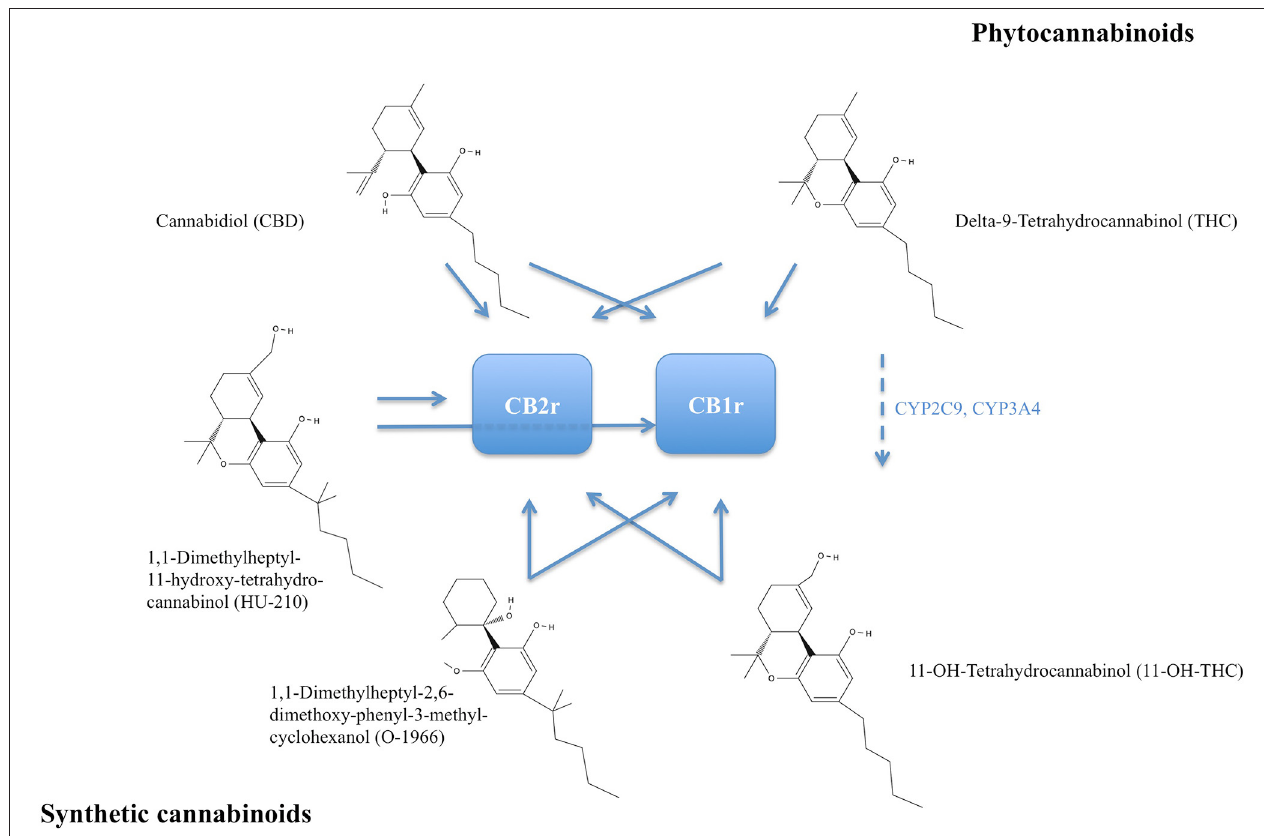
FIGURE 1 | Chemical structures of major phytocannabinoids: Delta-9-Tetrahydrocannabinol (THC) and Cannabidiol. Delta-9-THC is metabolized to 11-OH-Tetrahydrocannabinol by cytochrome P450 2C9 (CYP2C9) and cytochrome P450 3A4 (CYP3A4), broken arrow. Synthetic analogs 1,1-Dimethylheptyl-11-hydroxy-tetrahydro-cannabinol (HU-210) and 1,1-Dimethylheptyl-2,6-dimethoxy-phenyl-3-methyl-cyclohexanol (O-1966). Receptor affinity indicated by blue arrows. THC and 11-OH-THC are psychoactive and both more selectively binding to the CB1 receptor (CB1r). CB2r, CB2